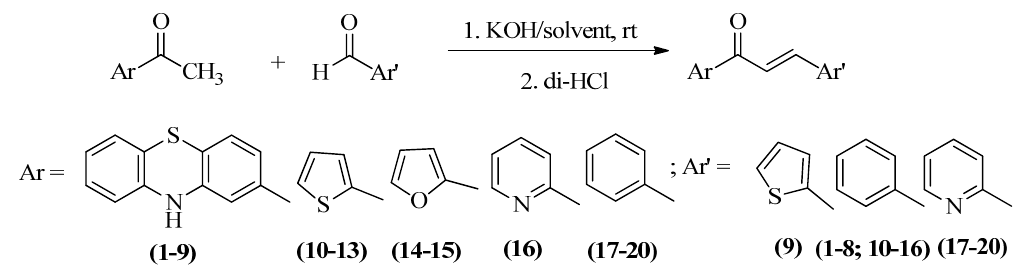
Scheme 1. General key step for the synthesis of heterocyclic chalcones. Table 1. Group of chalcone analogues with ring A as phenothazine moiety.